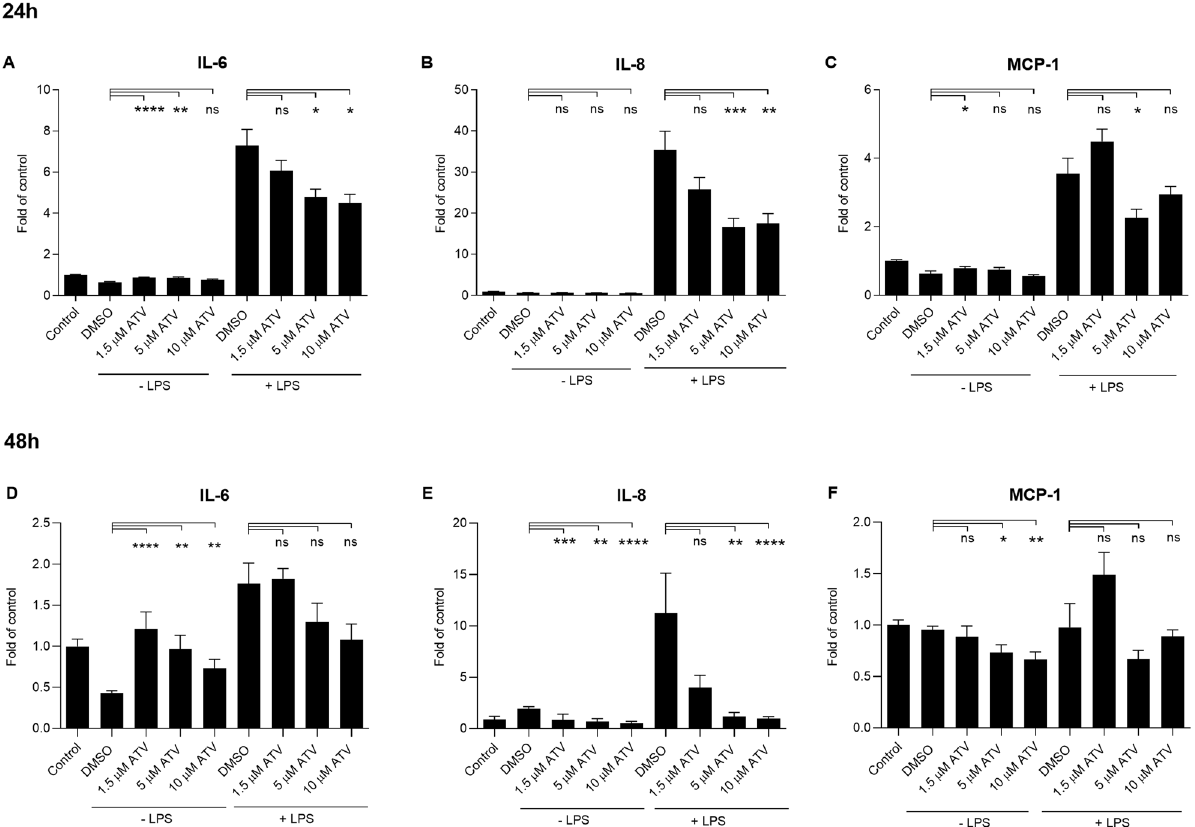
Figure 2. The effect of atorvastatin (ATV) on the production of pro-inflammatory cytokines in human RPE cells. The levels of IL-6, IL-8, and MCP-1 were measured following the 24 h ( A – C ) or 48 h ( D – F ) exposure to ATV with or without additional exposure to LPS for 24 h. The results are represented as fold of control, which was set to be 1. Results are combined from 4 independent experiments with 4 parallel samples per group in each experiment ( A – C ) and from 3 independent experiments with 4 parallel samples per group in each experiment ( D – F ) and shown as mean ± SEM. *P < 0.05, **P < 0.01, ***P < 0.001, ****P < 0.0001, ns not significant, Mann– Whitney U